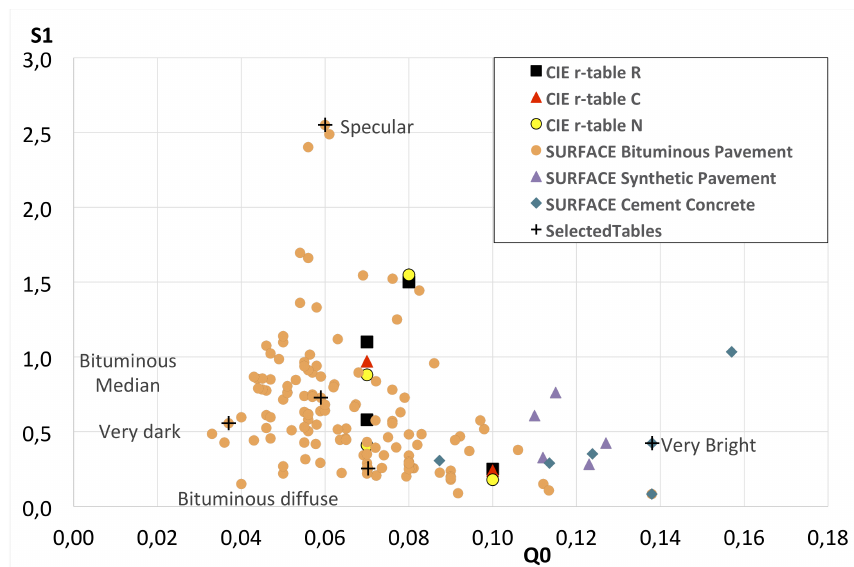
Figure 3. Q 0 and S 1 values of road surfaces in Table 2 and the current SURFACE database composed of 138 stabilised pavements.